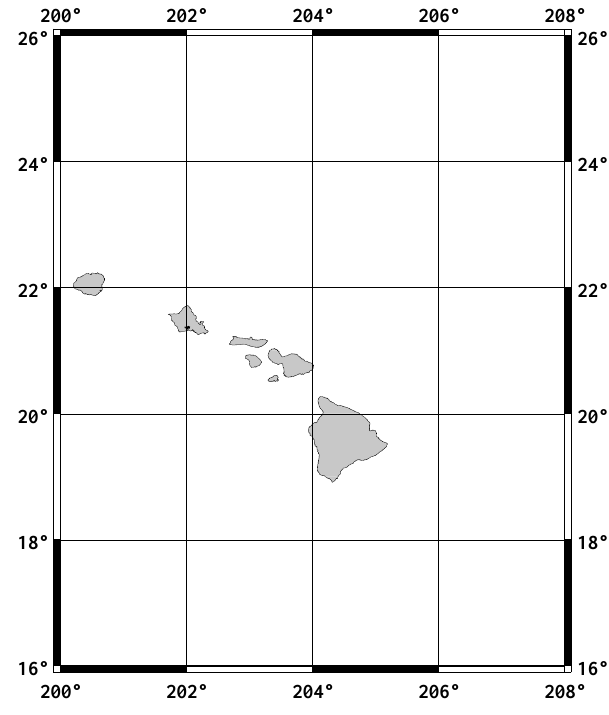
Fig. 2. A region centred over Hawaii subdivided into 20 2 ◦ × 2 ◦ grid